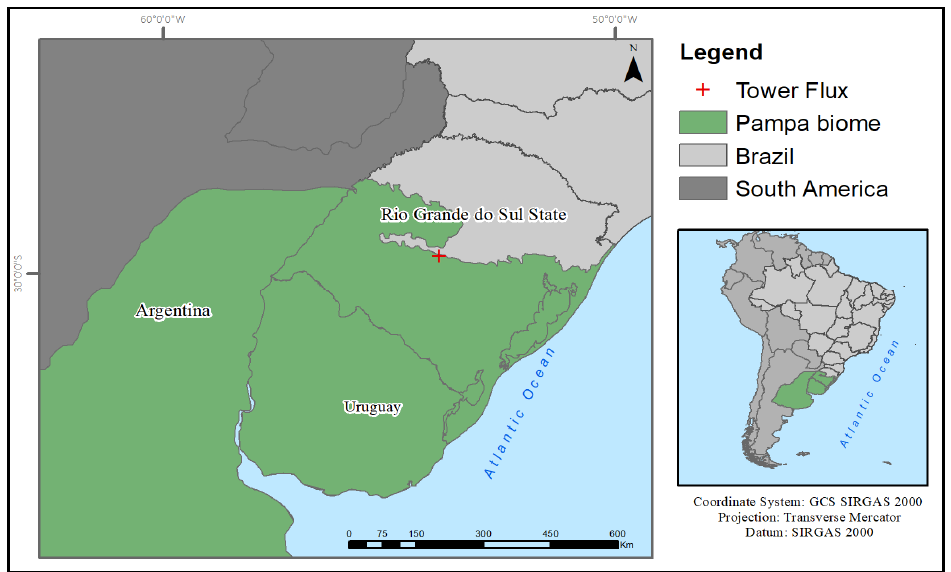
Figure 1. American Pampa Biome and Tower Flux location.